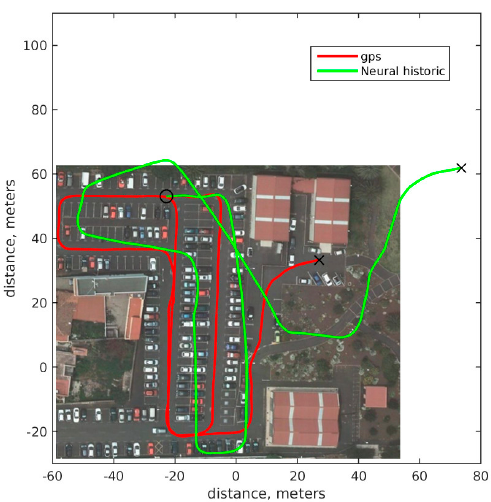
Figure 10. Neural model trains including history information. Solid red ground truth GPS route. Solid green historical neural calculation route.